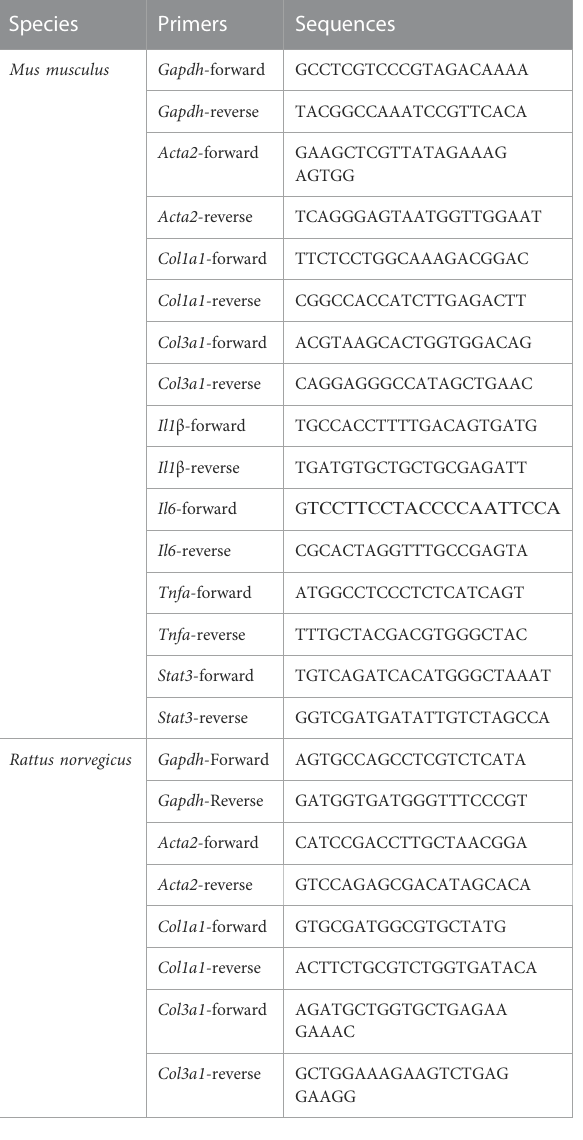
TABLE 1 Sequences of primers used for RT-qPCR.